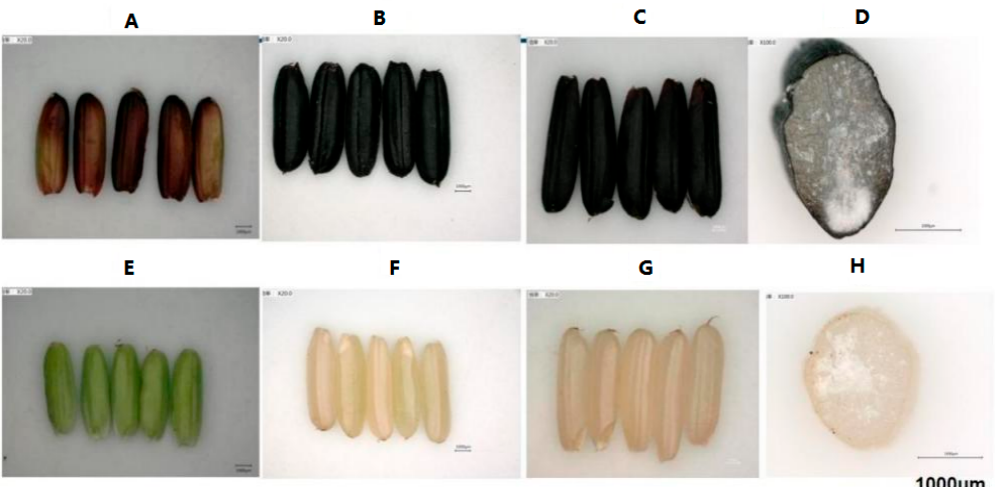
Figure 1. Developmental stages of black and white caryopsis; ( A ) black rice caryopsis at milk stage 11 days after flowering (Bc11); ( B ) black rice caryopsis at dough stage 18 days after flowering (Bc18); ( C ) black rice caryopsis at mature stage 25 days after flowering (Bc25); ( D ) a cross section of black caryopsis 20 days after flowering; ( E ) white rice caryopsis at milk stage 11 days after flowering (Wc11); ( F ) white rice caryopsis at dough stage 18 days after flowering (Wc18); ( G ) white rice caryopsis at mature stage 25 days after flowering (Wc25); ( H ) a cross section of white rice caryopsis 20 days after flowering.